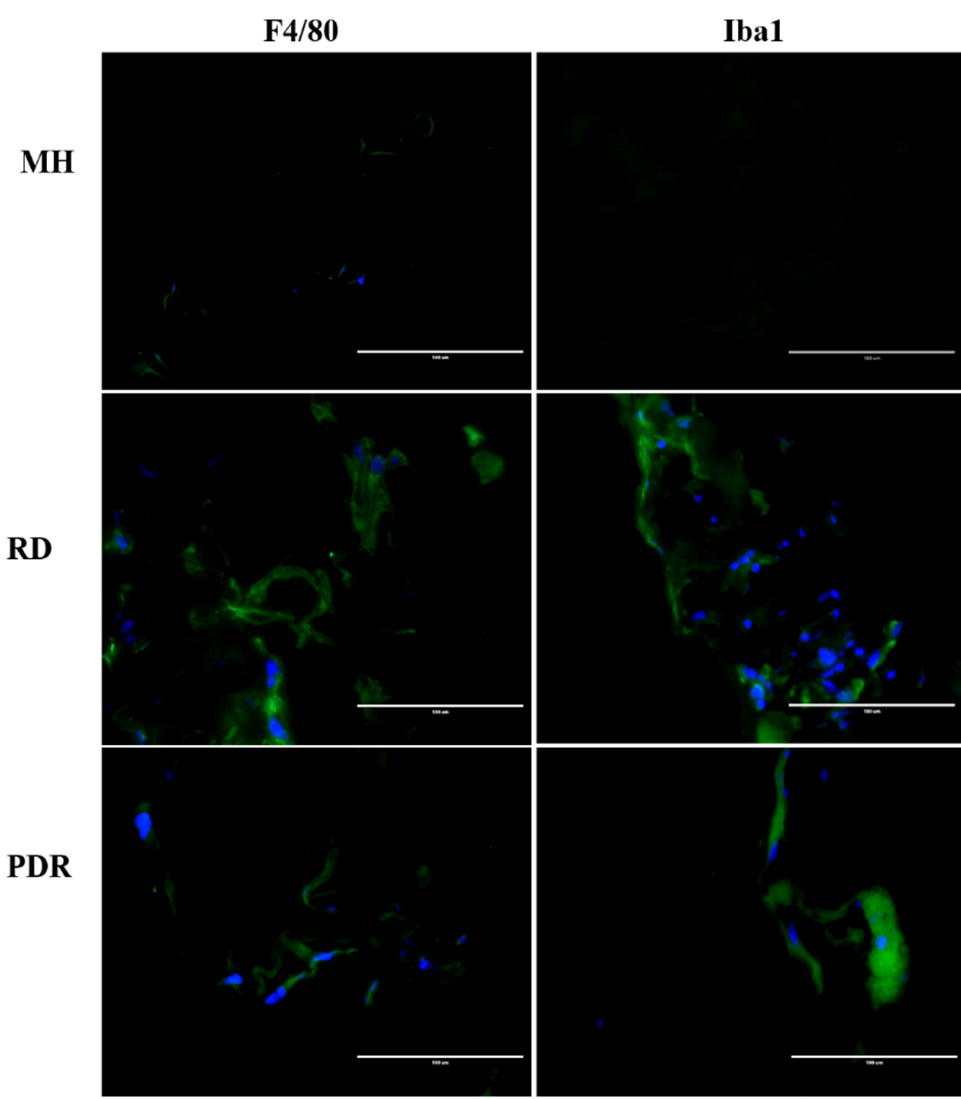
Figure 6. Validation of activation of microglia on the membrane shown by immunohistochemistry using marker for resting; F4/80 and activated stage; Iba1 in different pathological conditions MH, RD and PDR; scale bar; 100 μ m.